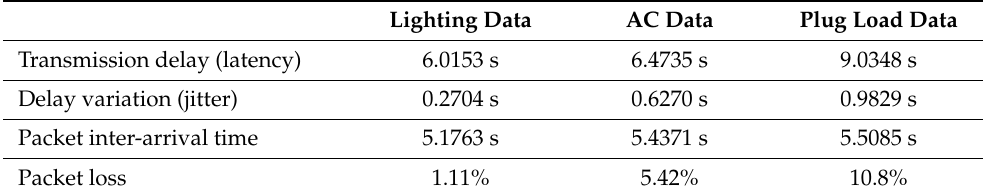
Table 6. IoT data transmission